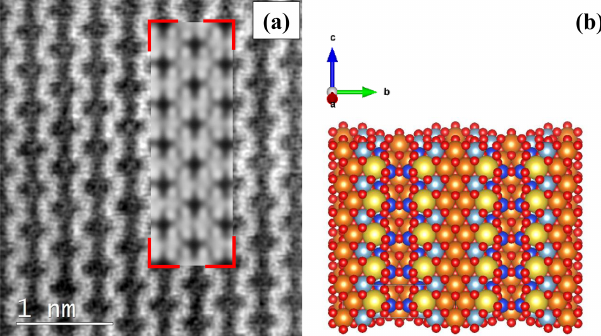
Figure 13. (a) Denoised atomic-resolution acSTEM picture of the chain-like structure of glaucophane. The simulated structure (delim- ited by red corners) is superimposed onto the real image. (b) Struc- tural model, oriented to be consistent with the structure imaged in panel (a) , was used to generate the simulated atomic-resolved crys- tal structure (delimited by red corners) in panel (a) . Si atoms are blue, Mg- or Fe-atom positions are orange, O atoms are red, Al atoms are light blue, and Na atoms are